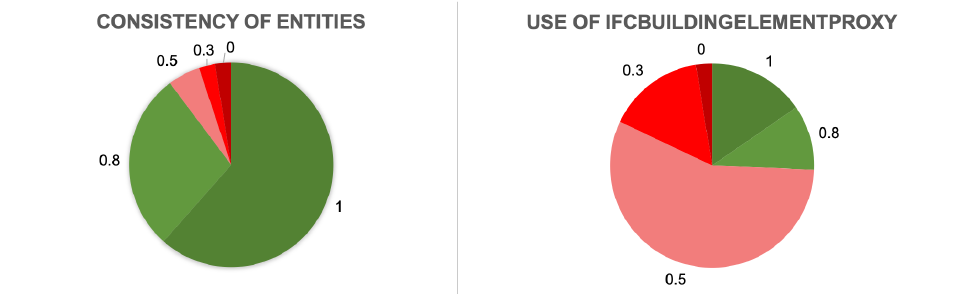
Figure 5. Distribution of models according to the assigned score about the consistency of entities and use of IfcBuildingElementProxy